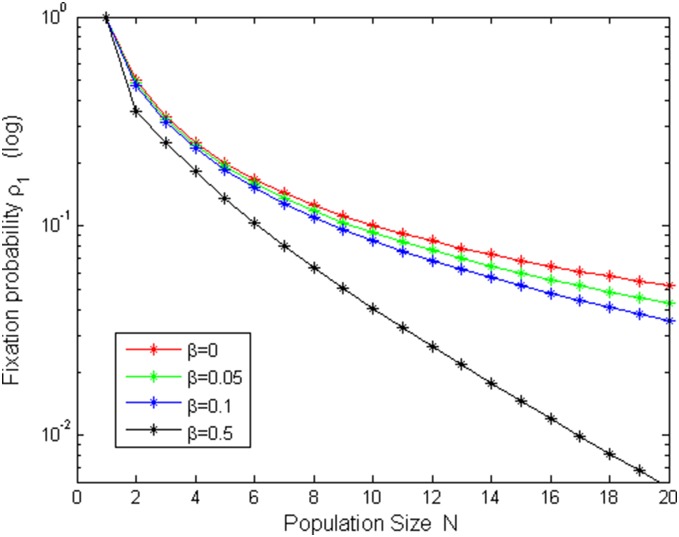
ρ1 vs N with µ = 1/4000, b = 1.2 and different β values.